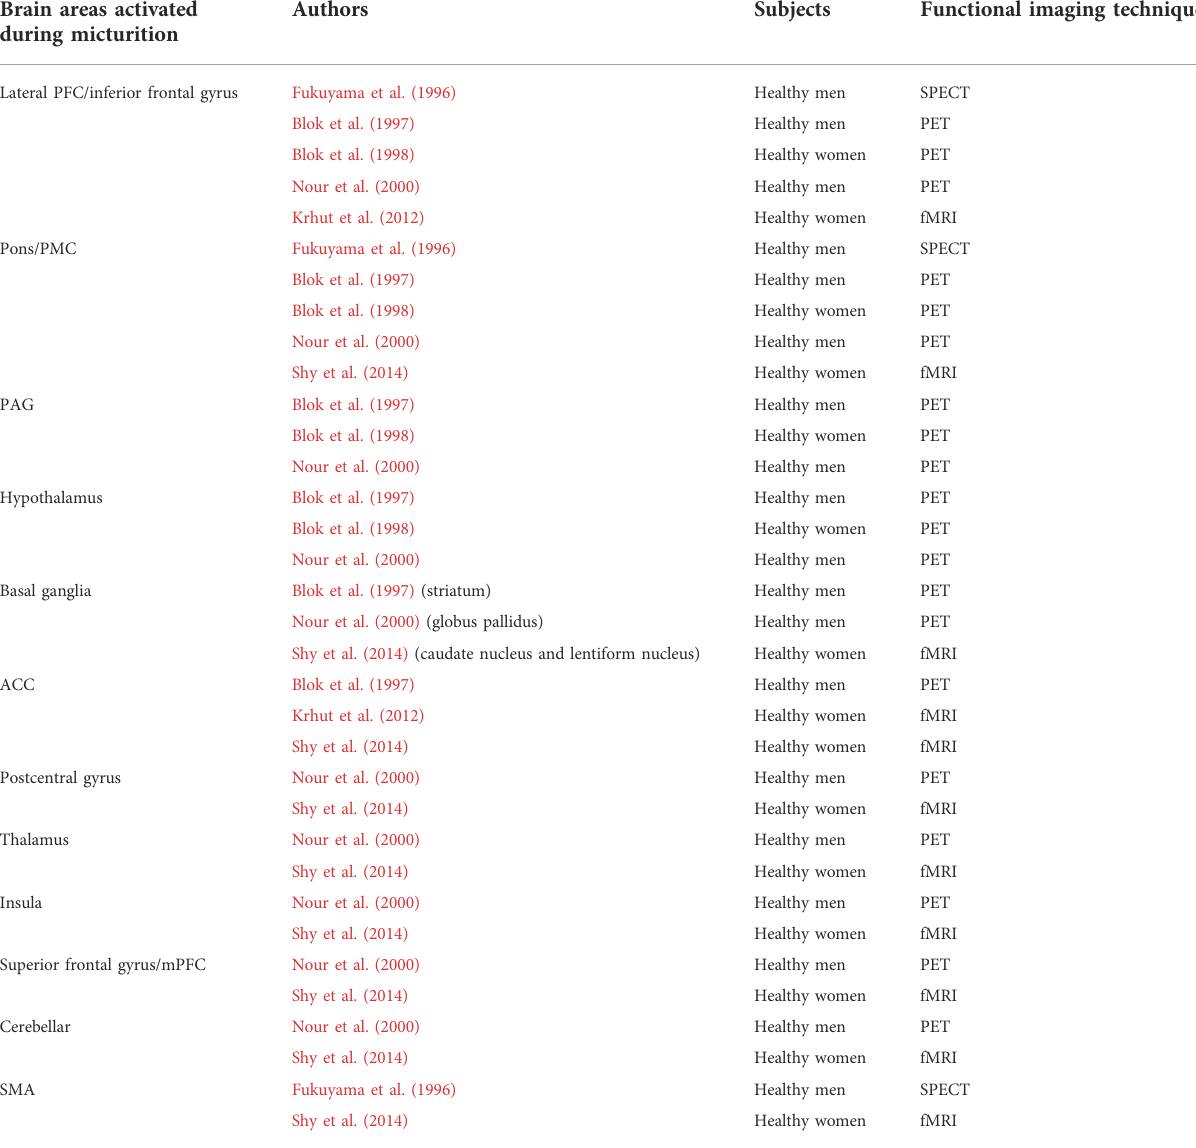
TABLE 1 Brain areas activated during